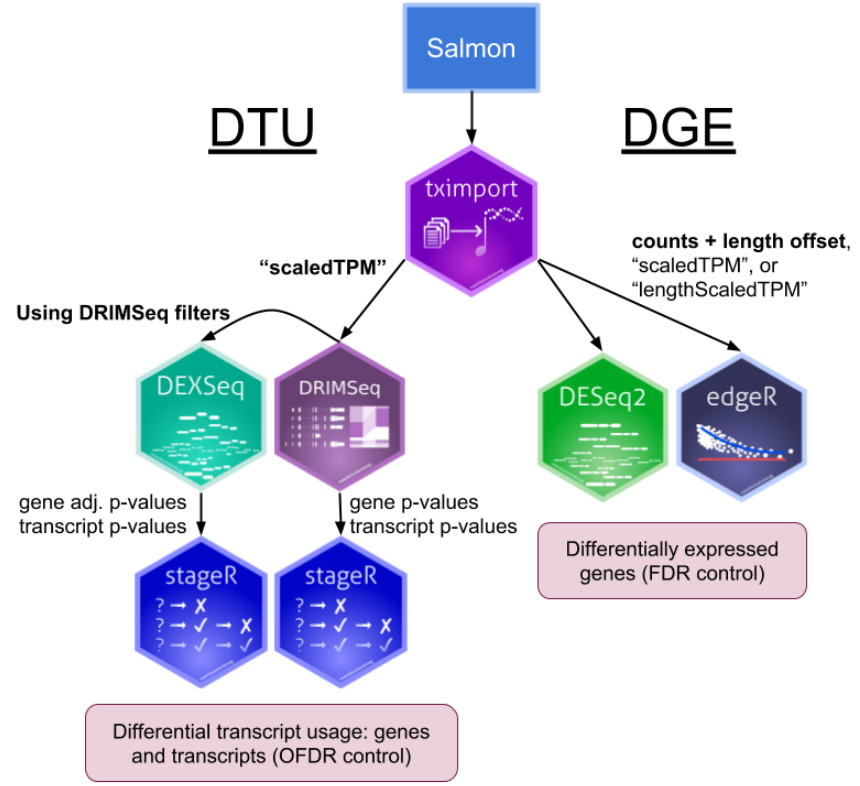
Figure 1. Diagram of the methods presented in this workflow. The left side shows two paths for performing differential transcript usage (DTU) using Bioconductor packages and the right side shows two paths for performing differential gene expression (DGE). DTU and DGE are complementary analyses of changes in transcription across conditions. This workflow focuses mostly on DTU, as there are a number of other published Bioconductor workflows for DGE. In bold are the recommended choices for quantification and filtering Salmon transcript-level data as input to the statistical methods. The recommended filters implemented in DRIMSeq, and applied upstream of DRIMSeq and DEXSeq, are discussed in this